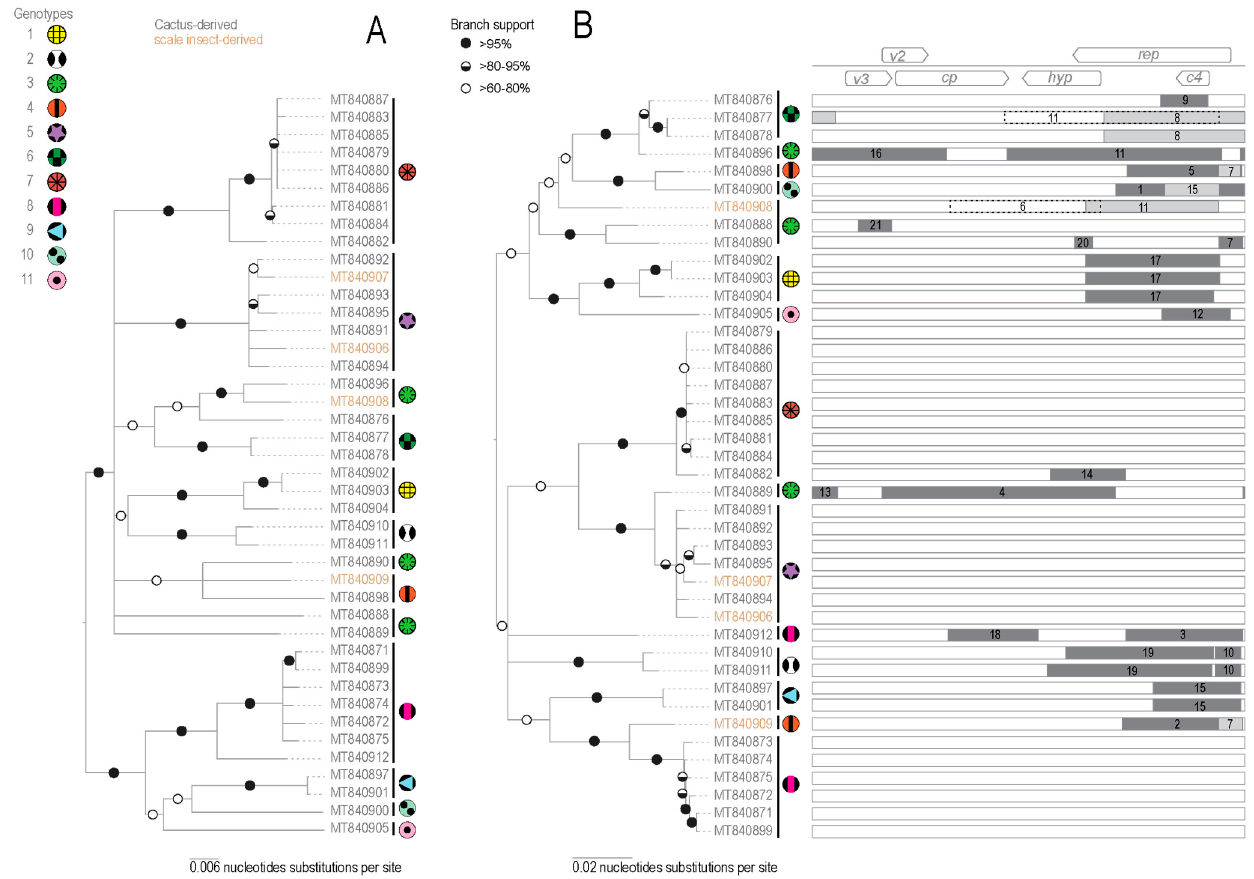
Figure 3. ( A ) Neighbor-joining phylogenetic tree of the 42 OpV2 sequences with genotypes denoted by symbols. ( B ) Maximum-likelihood phylogenetic tree of the 42 OpV2 sequences with recombination regions removed. The eleven genotypes of OpV2 are represented by symbols. Graphical representation of each genome representing the recombination event with the breakpoint location within the genome. Table 2. Summary of the 21 recombination events detected in the OpV2 sequences by RDP5 v5.5. The methods used to detect recombination were RDP (R), GENCONV (G), BOOTSCAN (B), MAXCHI (M), CHIMERA (C), SISCAN (S) and 3SEQ (T). The method with the highest p -value for each recombination event is bolded. Sites where the actual breakpoint is undetermined are marked with *. (T) denotes traces of recombination signals and (P) denotes partial evidence. Recombinant sequences marked with ˆ indicate that the recombinant sequence may have been misidentified (one of the identified parents might be the recombinant). Please refer to the table for accession # of the